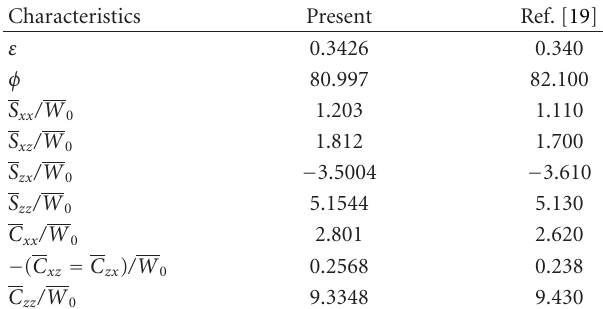
Table 2: Comparison of performance characteristics of two-lobe hydrodynamic journal bearing, L/D = 1, Ω = 1, δ = 0 . 5. W 0 = 5.0.